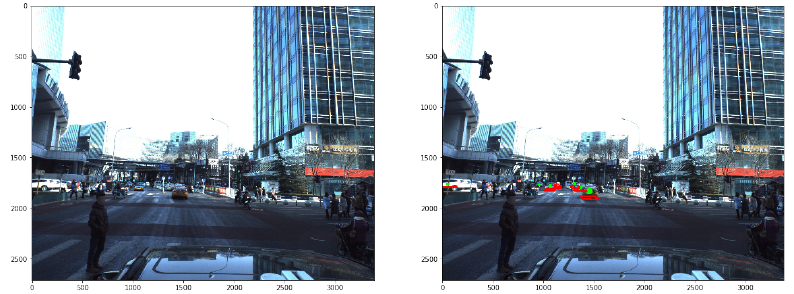
Figure 3. The original sample images ( left ) and the ones with ground truth labels ( right ).